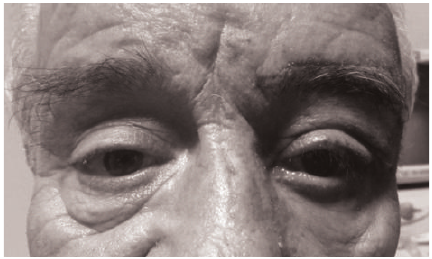
Figure 3: Postoperative 4-week view after brow lift with copy-paste- excise technique along with lateral canthal